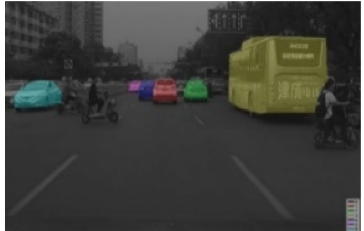
Figure 8. Instance segmentation annotation.